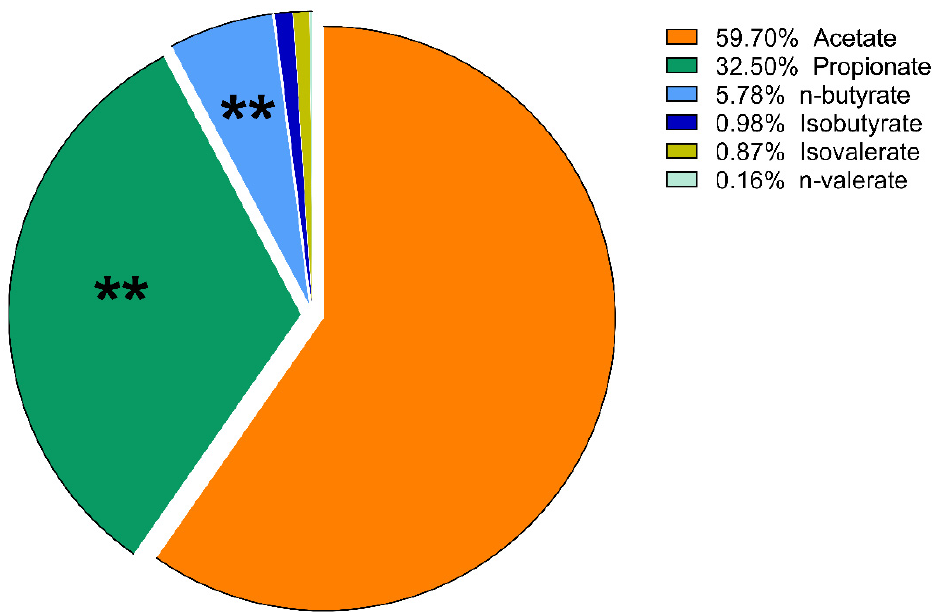
Figure 6. Volatile fatty acid profile of fecal samples of the lactulose group on day 5 of the experiment measured by GC-MS method. Data are expressed as mol%. ** p < 0.01.